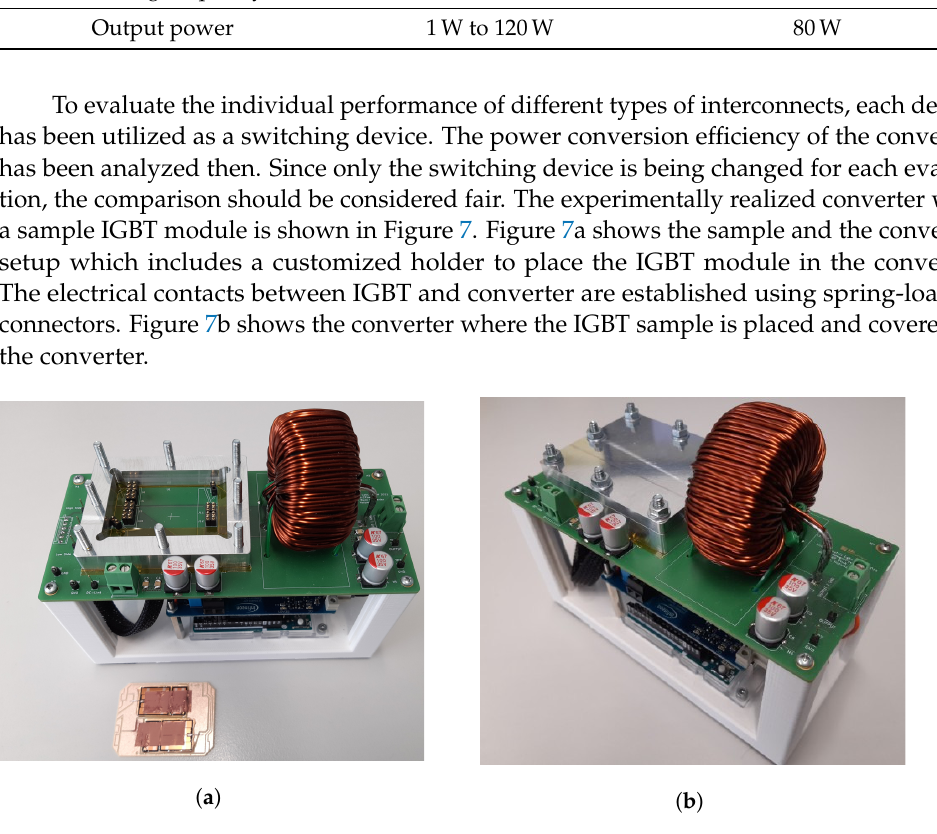
Figure 7. IGBT buck converter hardware photographs with control board (blue) underneath the main power board (green) having bulk energy storage capacitor and inductor components. ( a ) View with the IGBT-DBC half-bridge removed and not installed on the power board. ( b ) View with the DBC half-bridge mounted against the spring pressure